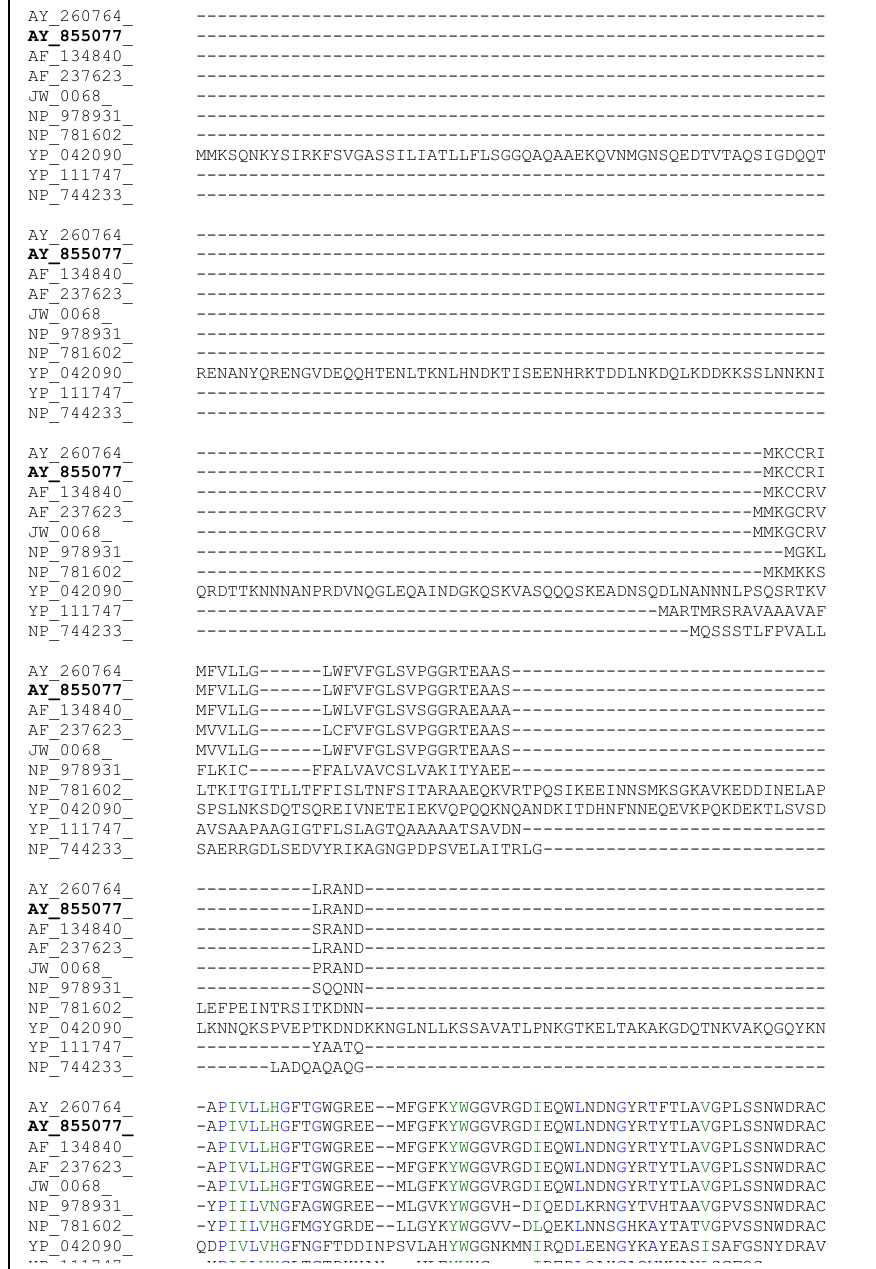
Figure 2. Homology lineup of lipases from several bacteria